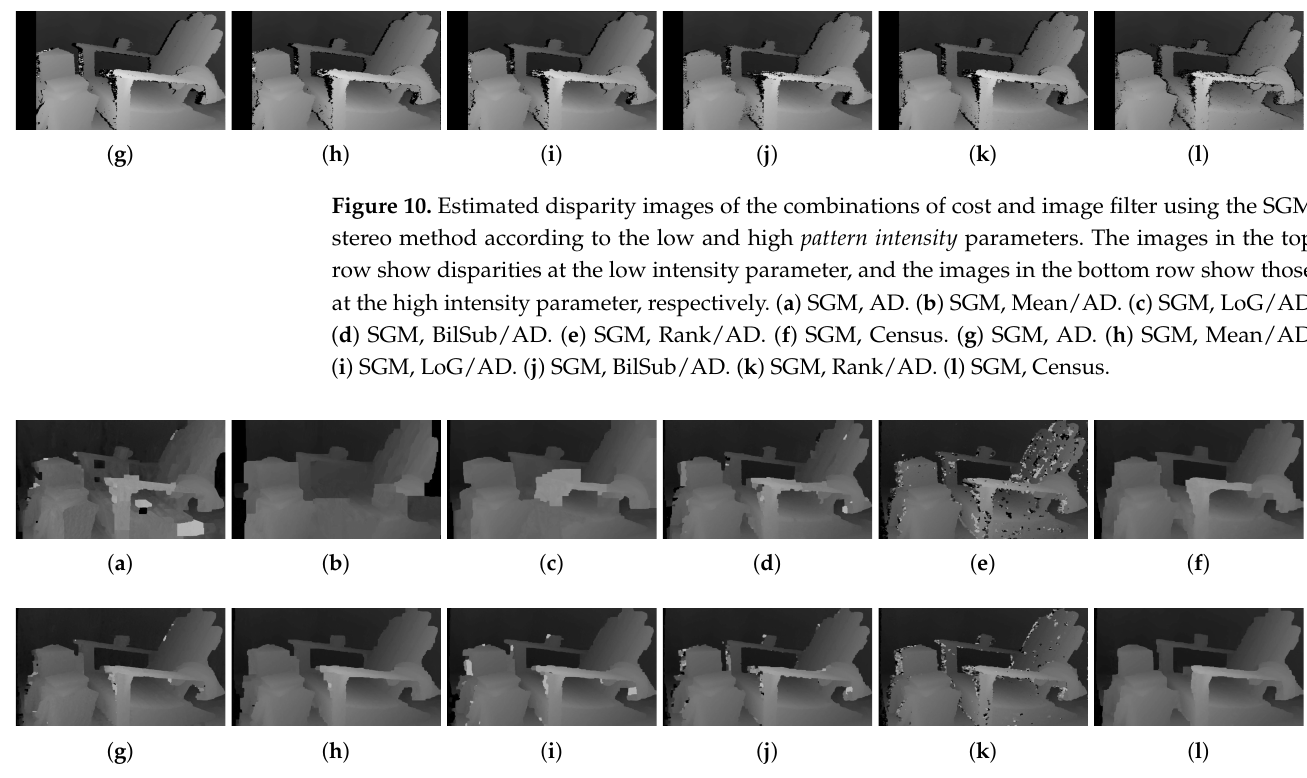
Figure 11. Estimated disparity images of the combinations of cost and image filter using the GC stereo method according to the low and high pattern intensity parameters. The images in the top row show disparities at the low intensity parameter, and the images in the bottom row show those at the high intensity parameter, respectively. ( a ) GC, AD. ( b ) GC, Mean/AD. ( c ) GC, LoG/AD. ( d ) GC, BilSub/AD. ( e ) GC, Rank/AD. ( e ) GC, Census. ( g ) GC, AD. ( h ) GC, Mean/AD. ( i ) GC, LoG/AD. ( j ) GC, BilSub/AD. ( k ) GC, Rank/AD. ( l ) GC,